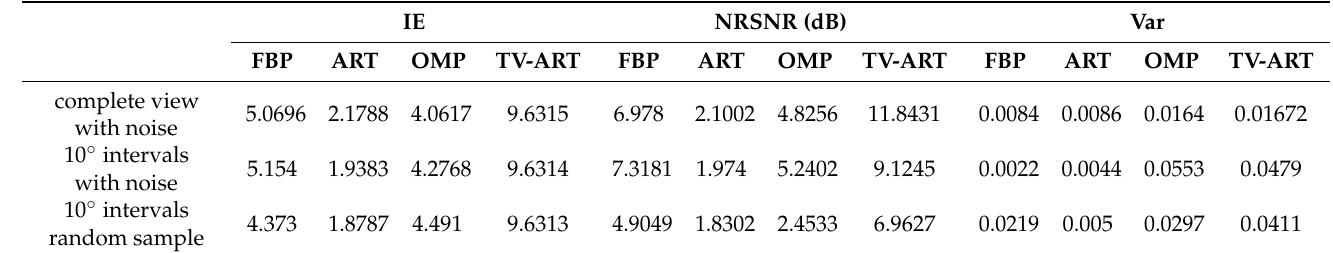
Table 5. IE, NRSNR, and Var value of anti-noise and random sampled results.